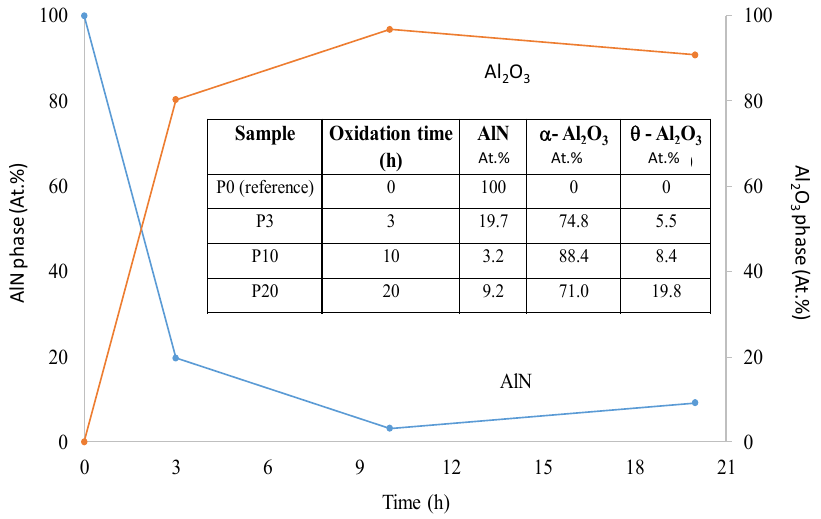
Figure 1. The schematic of oxidation of AlN powder and corresponding sintering process along with the parameters of processing.